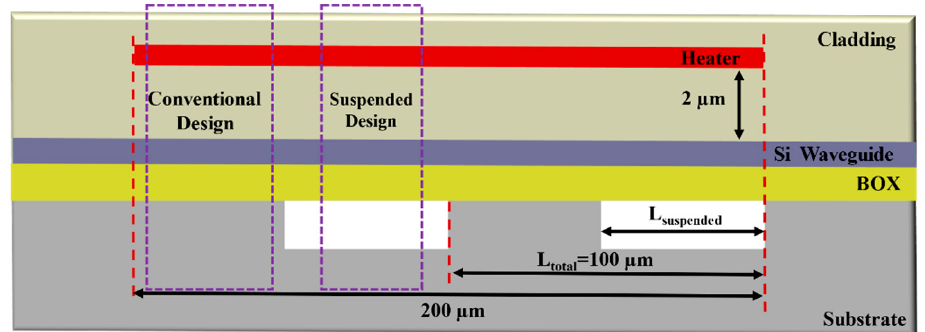
Figure 1. Section view of thermo-optic phase shifter with interleaved suspended design.